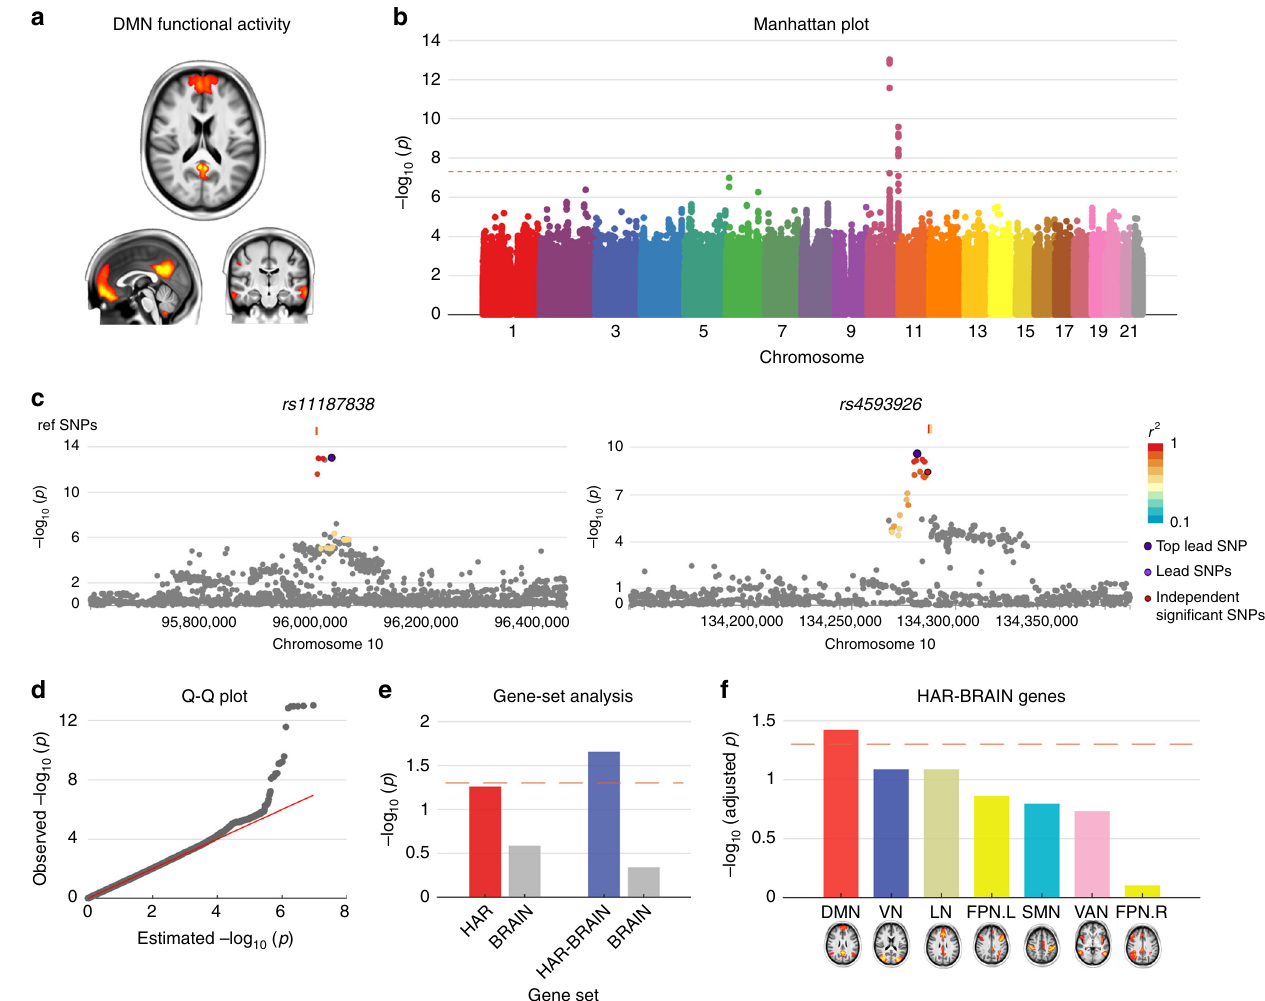
Fig. 4 GWAS on DMN activity. a DMN component. b GWAS Manhattan plot showing – log 10 -transformed two-tailed p -value for all SNP ( y -axis) and base- pair positions along the chromosomes ( x -axis). Dotted red line indicates Bonferroni-corrected genome-wide signi fi cance ( p -value < 5 × 10 − 8 ). c Regional plots of the two genomic loci (left, lead SNP: rs11187838 and right, lead SNP: rs4593926 ). d Q – Q plot of SNP-based p -value in panel b . Observed − log 10 transformed two-tailed p -values of associations with DMN functional activity are plotted against expected null p -values for all SNPs in the GWAS. e MAGMA conditional gene-set analysis. − log 10 -transformed p -values of the associations between HAR/HAR-BRAIN genes and DMN functional activity conditional upon BRAIN genes. Dashed line indicates p = 0.05. f MAGMA gene-set analysis on HAR-BRAIN genes and other “ NETMAT amplitude 25 ” phenotypes representing functional activity in the other functional networks ( − log 10 -transformed adjusted p- values, FDR corrected). Colors indicate the assignment of functional networks, as in Fig. 2b. Dashed line indicates adjusted p =